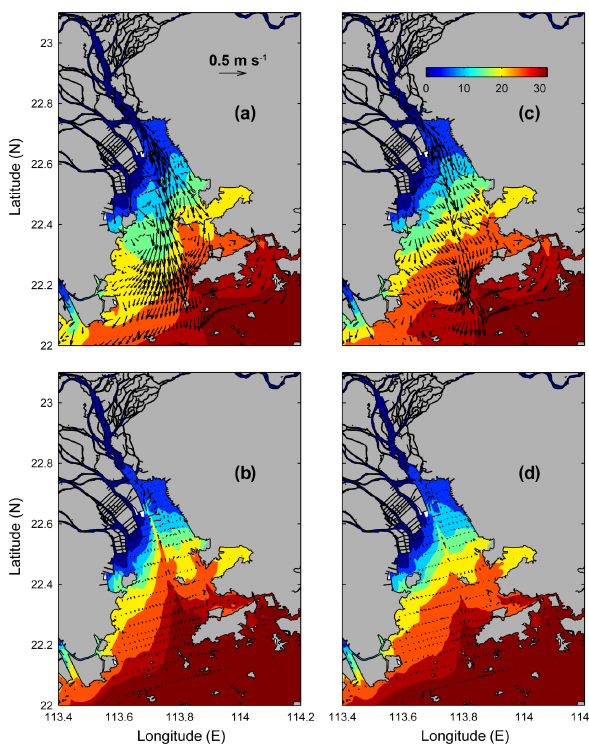
Figure 4. The modelled distribution of 50h of averaged salinity and current. Panel (a) the surface; panel (b) the bottom during a neap tide; panel (c) the surface; panel (d) the bottom during a spring